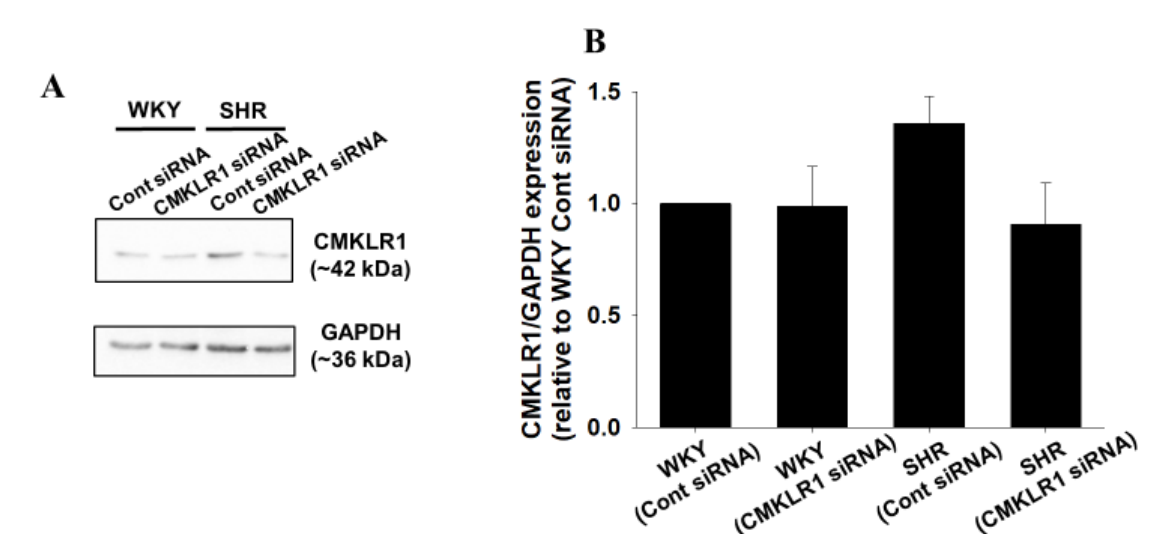
Figure 4. Effects of CMKLR1 siRNA on protein expression of CMKLR1 in paraventricular nucleus (PVN). Cont siRNA (0.04 nmol/head, i.c.v.) or CMKLR1 siRNA (0.04 nmol/head, i.c.v.) was administered to male WKY or SHR. One day later, protein expression of CMKLR1 in PVN was determined by Western blotting. Representative blots were shown ( A ). The normalized CMKLR1 expression relative to GAPDH expression was shown as relative to WKY (Cont siRNA). Data were shown as mean ± SEM in bar graph (( B ): n = 4).